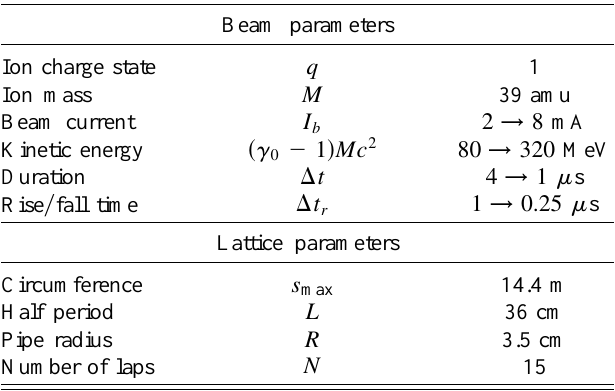
TABLE I. Nominal parameters of the LLNL small